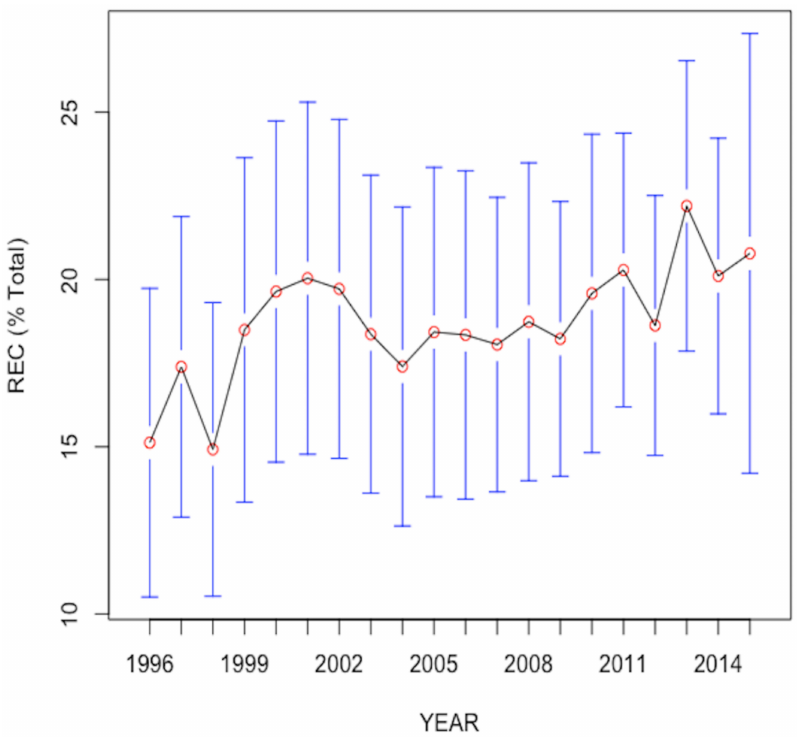
Figure 2. The evolution of mean renewable energy consumption (REC) at world level (with confi- dence intervals). Source of data: World Bank’s Development Indicators (WDI)